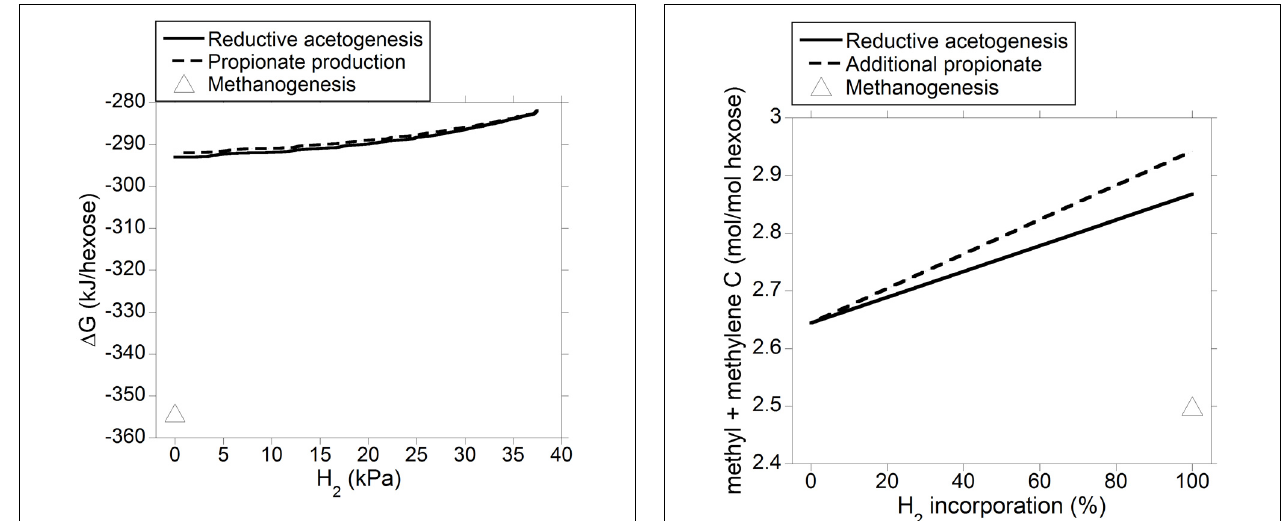
FIGURE 8 | Response in total VFA methyl plus methylene groups output to H 2 incorporation into reductive acetogenesis or additional propionate formation. Corresponding fermentation with CH 4 as main electron sink is provided as